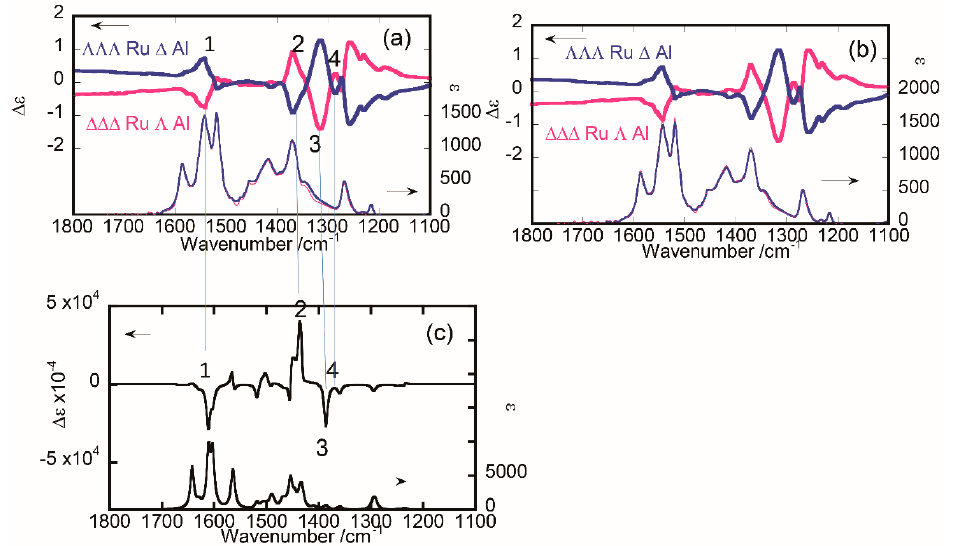
Figure 4. Vibrational circular dichroism (VCD) and IR spectra: ( a ) initial 10 min ( b ) final 1.5 h. [{ Λ -Ru(III)(acac) 2 (taet)} 3 Al(III)] (blue) or [{ ∆ -Ru(III)(acac) 2 (taet)} 3 Al(III)] (red) in CDCl 3 ( c ) The calculated VCD and IR spectra of [ ∆ -Ru(III)(acac) 2 (taet)} 3 Λ -Al(III)] in a gas phase.